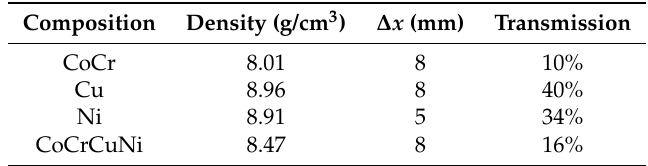
Table 1. Table of neutron transmission through the CoCr, Cu, Ni, and CoCrCuNi phases. Composition Density (g/cm 3 ) ∆ x (mm) Transmission CoCr